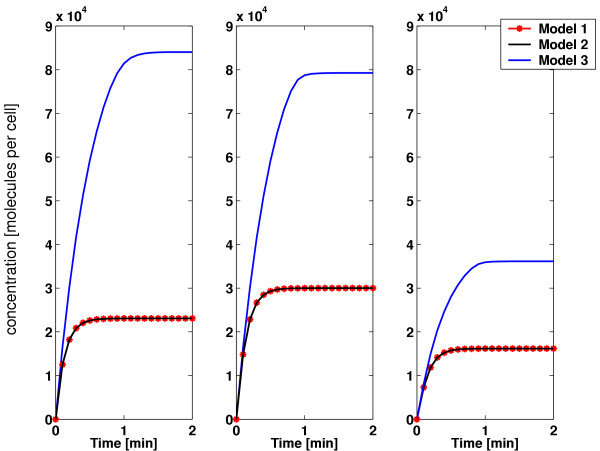
Dynamic simulations. Dynamic simulations of the example shown in Figure 3b using the parameter values presented in Table 5. Here we compare the levels of occupancy of the three protein domains. The left picture shows the level of occupancy of domain 1, the second picture shows the levels of occupancy of domain 2 and the right picture shows that of domain 3. The results show that the reduced model we obtained by applying our method (model 3) accurately describes the real time course represented by a complete mechanistic model (model 1). The other model which follows from a number of reasonable simplifications which can also be found in literature provides completely different results.